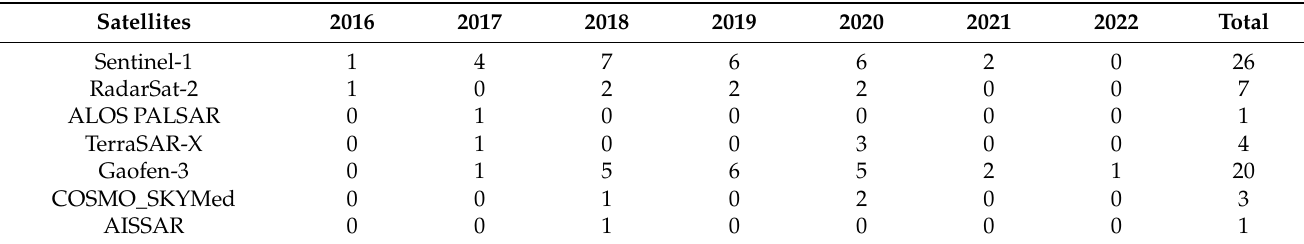
Table 3. The satellites that are used in the paper beside the datasets.